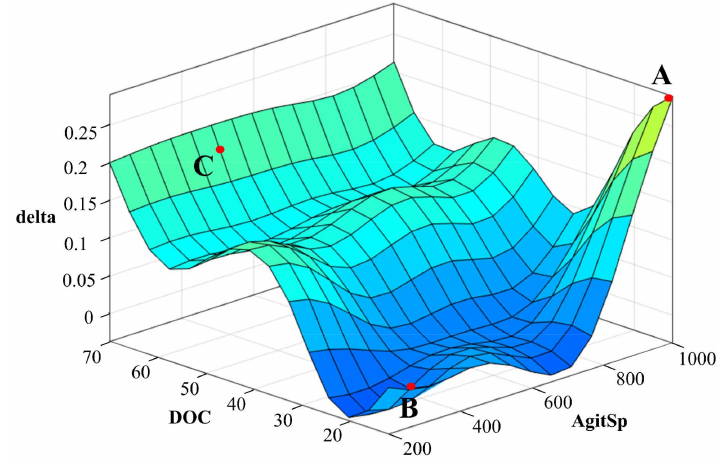
Figure 2. Delta surface response after ANFIS